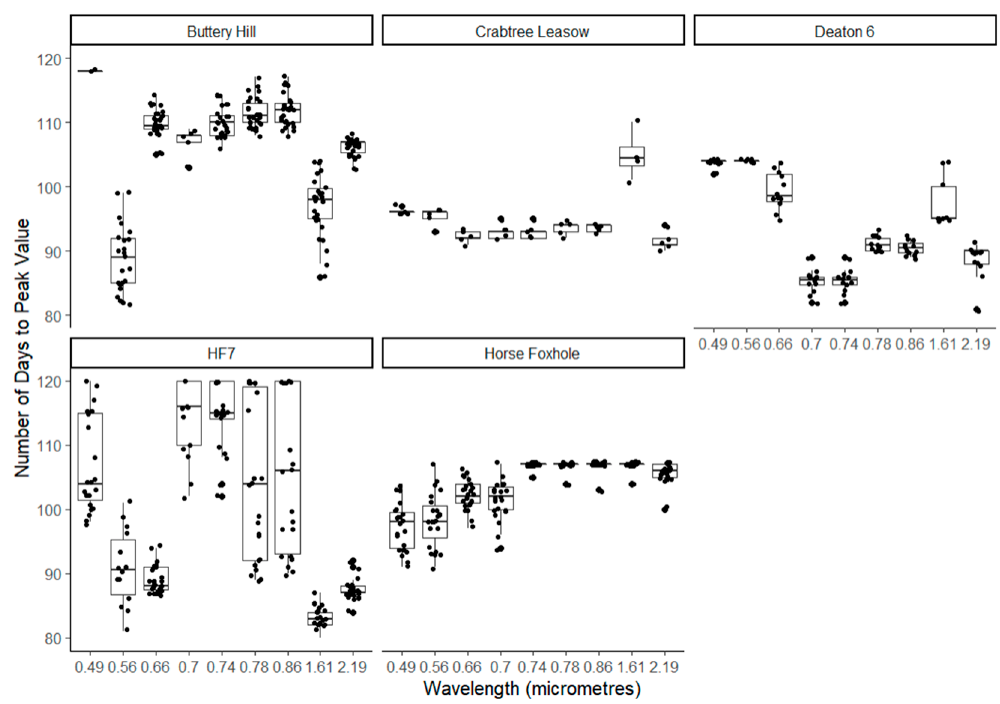
Figure 5. Illustration of the spread of the observed number of days between planting day and the peak value of each of the Sentinel-2 satellite wavebands.